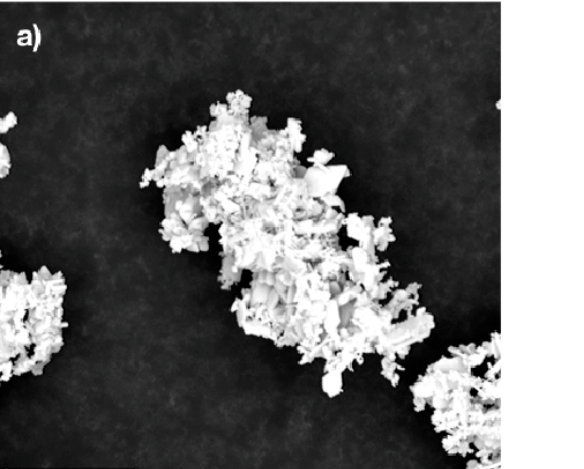
Figure 2. Example of an SEM image of the investigated AgNPs in a solid sample. Evidence of a typical charge effect of nonconductive samples (specimen) that were not treated with a “coated technique”. ( a ) The figure was obtained with the drop technique on a metal sample holder (specimen) covered with charcoal. ( b ) The figure represents the magnification useful for the elementary analysis.